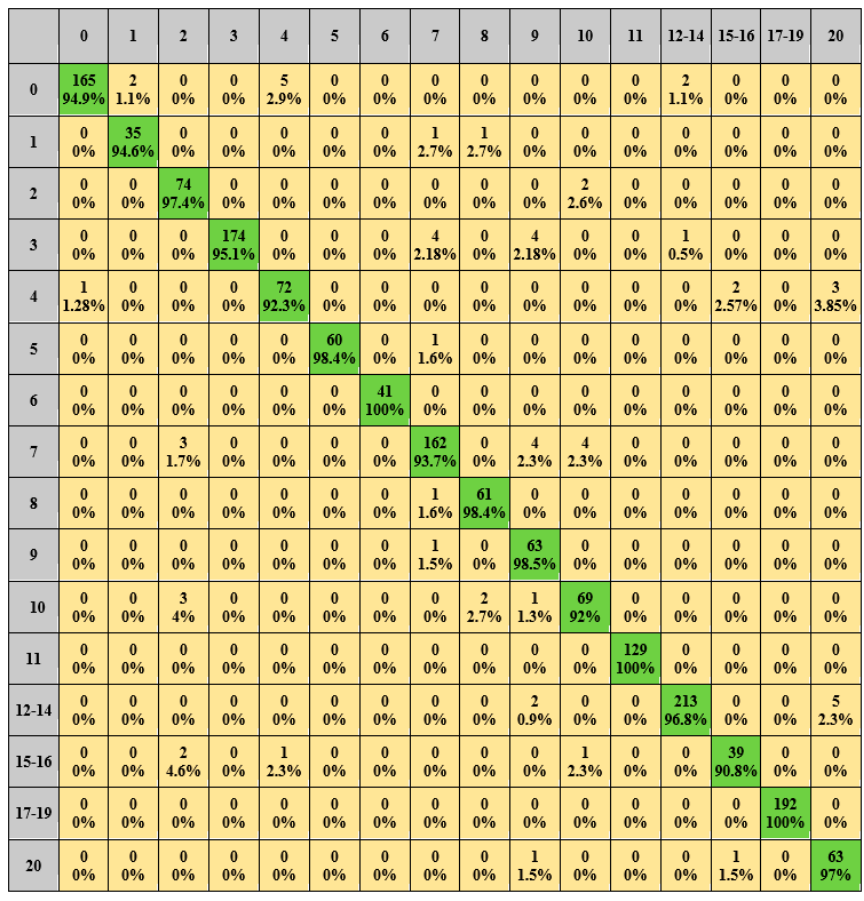
Figure 12. PLAID dataset identi fi cation results. ( Green means true, yellow means false )